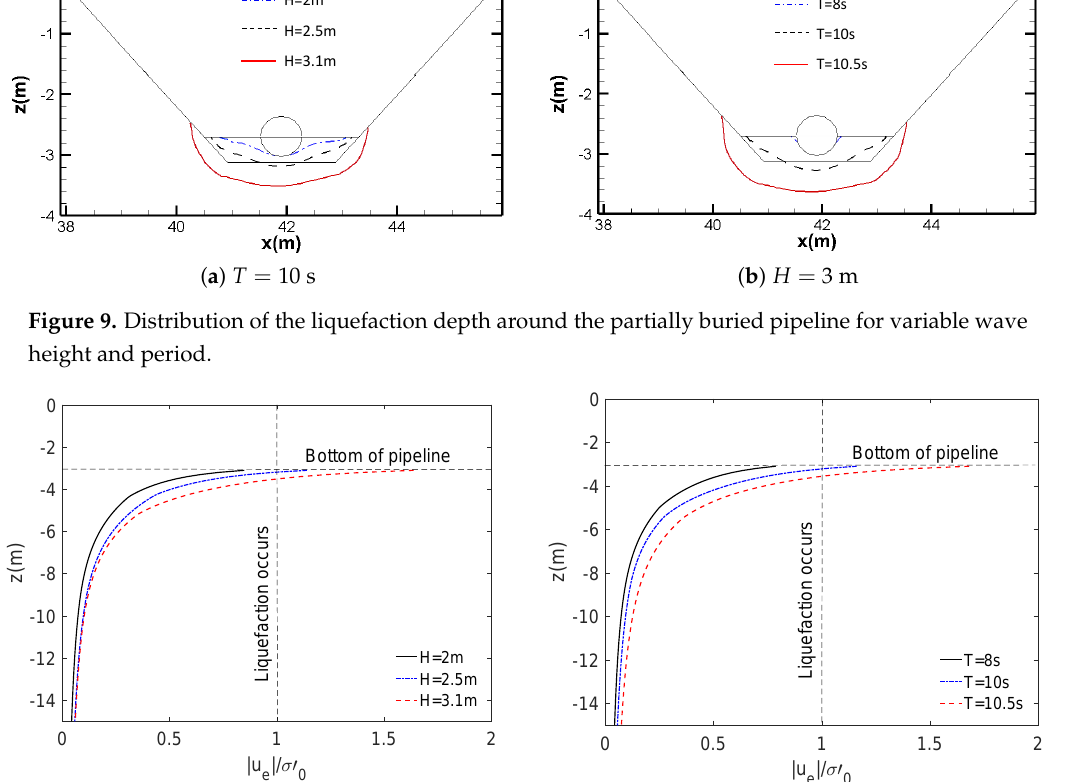
) under wave trough along the vertical 0